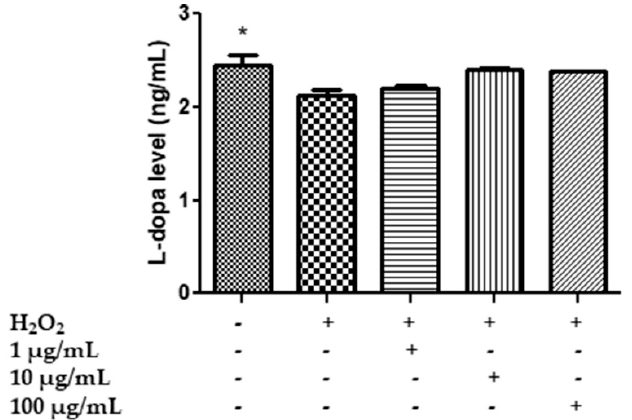
Figure 6. Effect of the HAE acetone water extract (1–100 µg/mL) on L-dopa level (ng/mL), in hypothalamic HypoE22 cells exposed to H 2 O 2 (µM). ANOVA p < 0.01; * p < 0.05 vs. H 2 O 2.